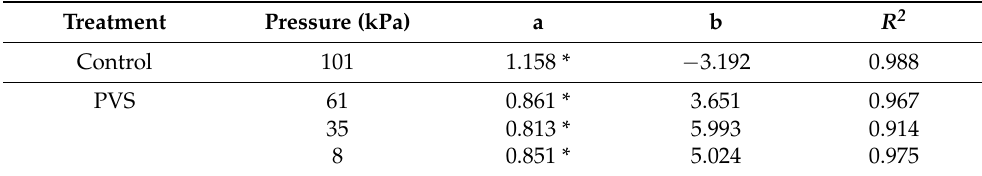
Figure 1. Image of the external surface and cross-sectioned for calcium-alginate hydrogel balls affected by different working pressures and pressurization time: ( a ) Pulse Pressurization Time = 20 min; ( b ) Pulse Pressurization Time = 180 min. Table 2. Linear regression 1 results showing the relation of weight reduction (WR) and volume shrinkage (S v ) during the external gelation process of calcium-alginate hydrogel balls with and without pulsed-vacuum